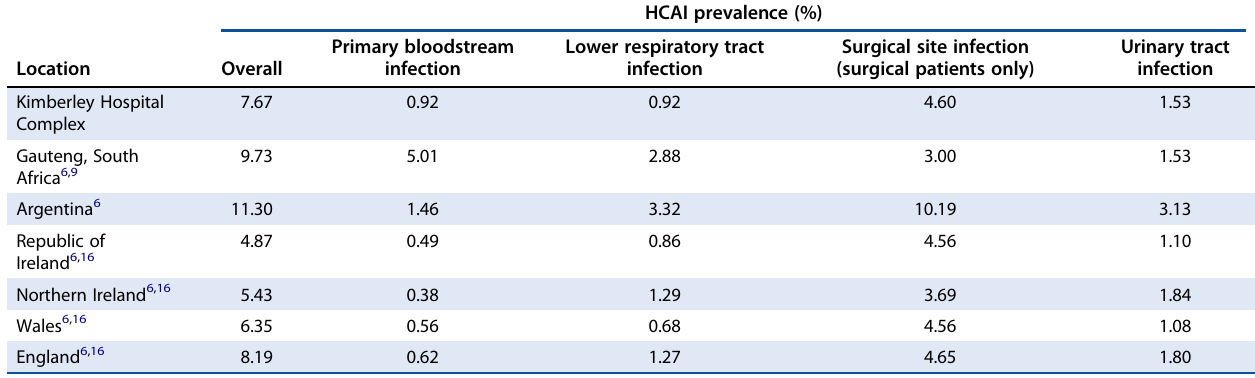
Table 4: Comparative healthcare-associated infection rates for Kimberley Hospital Complex and South Africa, Argentina, Ireland, Wales and England